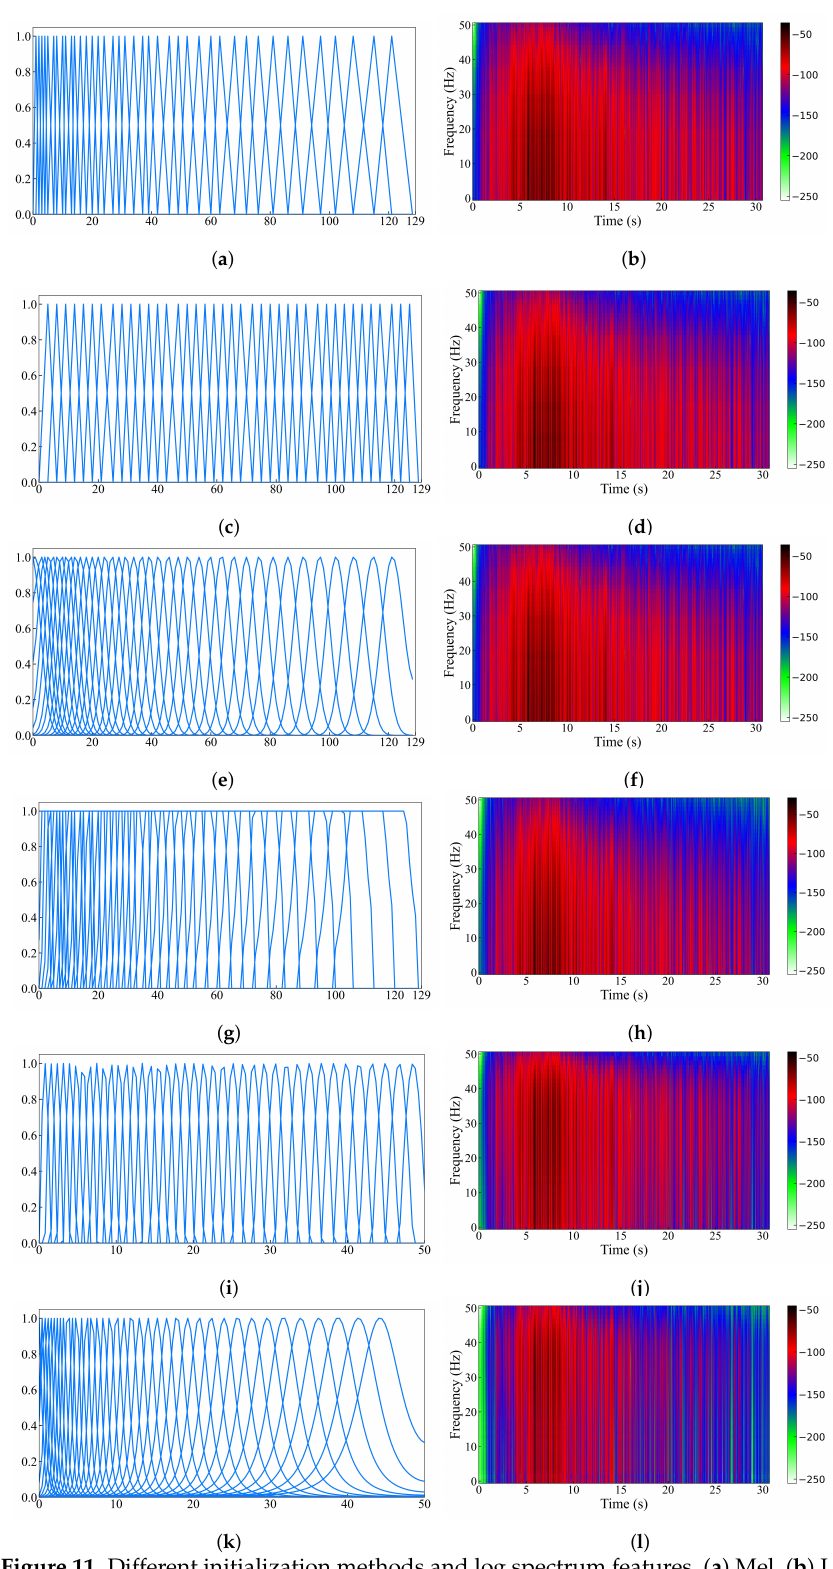
Figure 11. Different initialization methods and log spectrum features. ( a ) Mel, ( b ) Log Mel feature, ( c ) Linear, ( d ) Log Linear feature, ( e ) Gauss, ( f ) Log Gauss feature, ( g ) Bark, ( h ) Log Bark feature, ( i ) ERB, ( j ) Log ERB feature, ( k ) GammaTone, ( l ) Log GammaTone